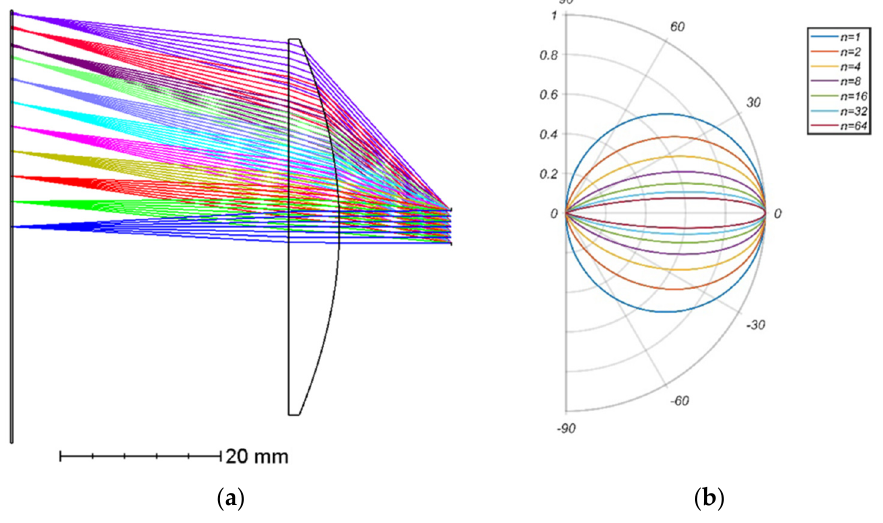
Figure 2. ( a ) Optical layout of the VR display module used in the simulation; ( b ) Exemplary angular intensity profiles of the display panel described in Equation (1).